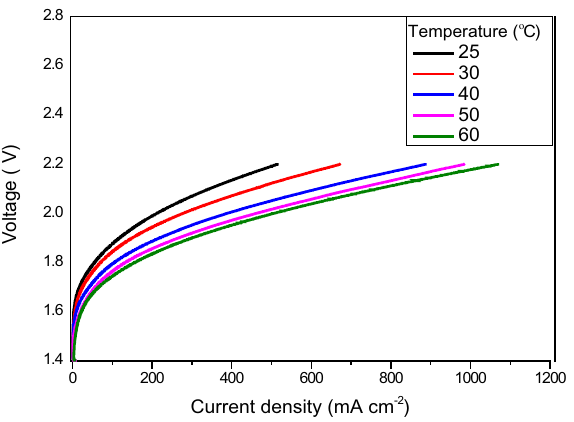
Figure 9. Polarization curves of AEM electrolyser recorded for 1 M KOH at different